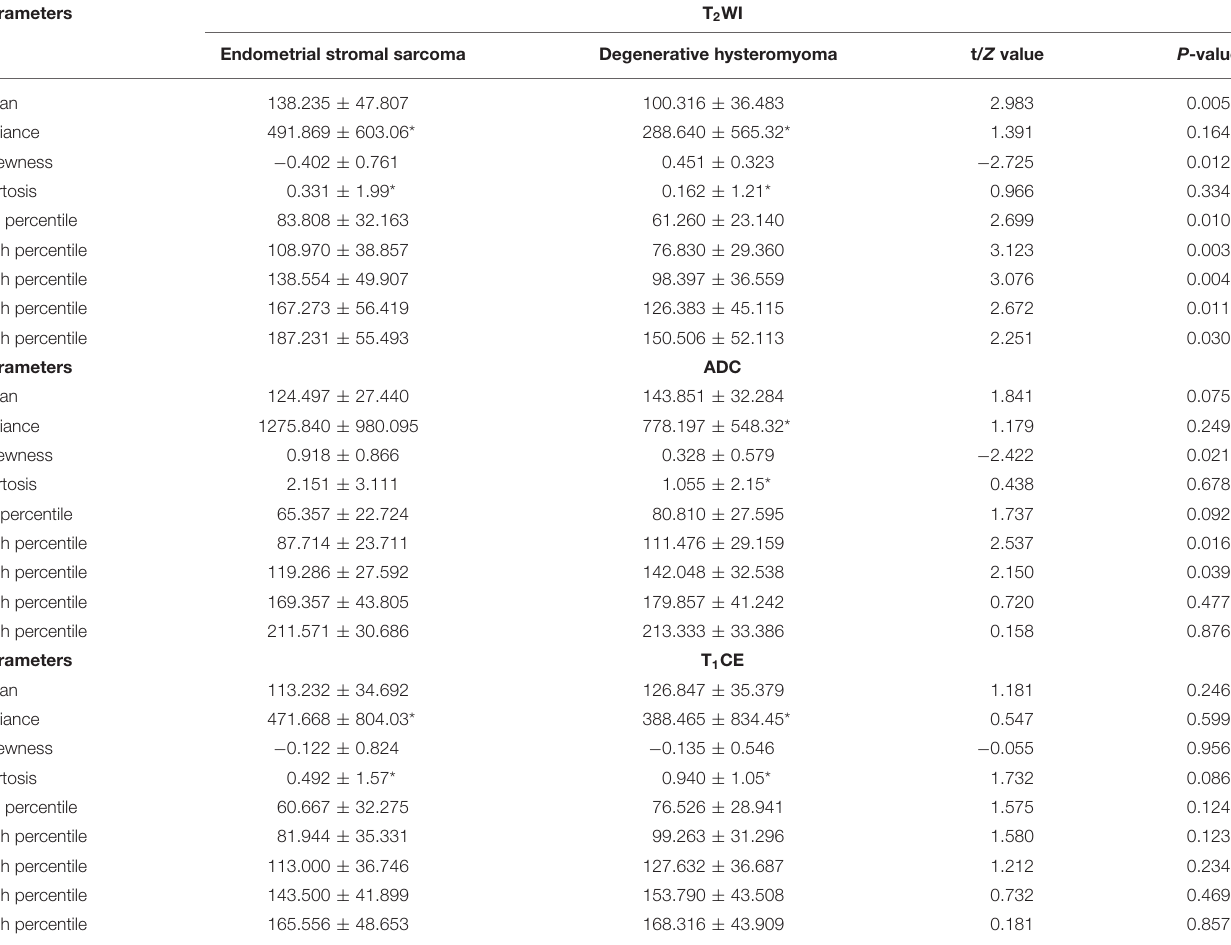
TABLE 4 | Comparison of histogram parameters between the endometrial mesenchymal sarcoma and degenerative hysteromyoma. Parameters